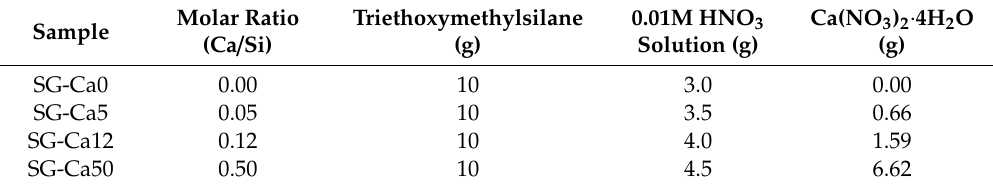
Figure 1. Sol-gel procedure to prepare silicon oxycarbide xerogel precursors with optical pictures of gels, aged gels, and xerogels. Table 1. Designed molar ratios for xerogel samples and the corresponding amounts of chemicals applied for the sol-gel